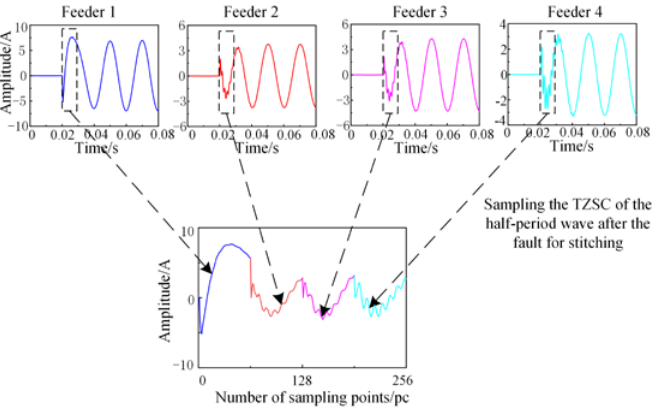
Figure 4. Fault data stitching method.